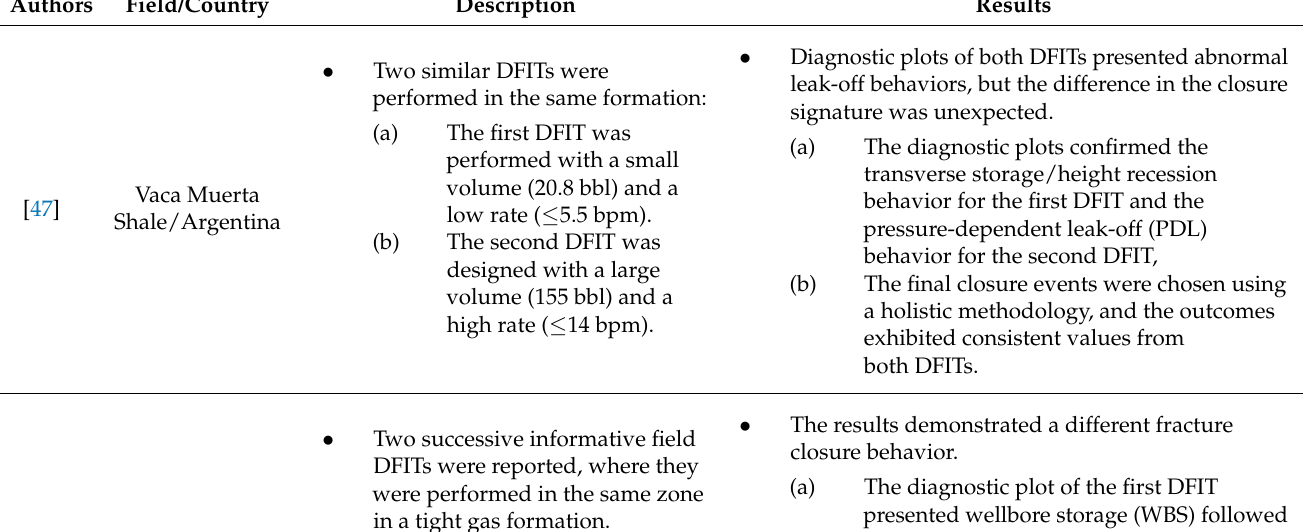
Table 9. Field case studies of DFIT operations and lessons